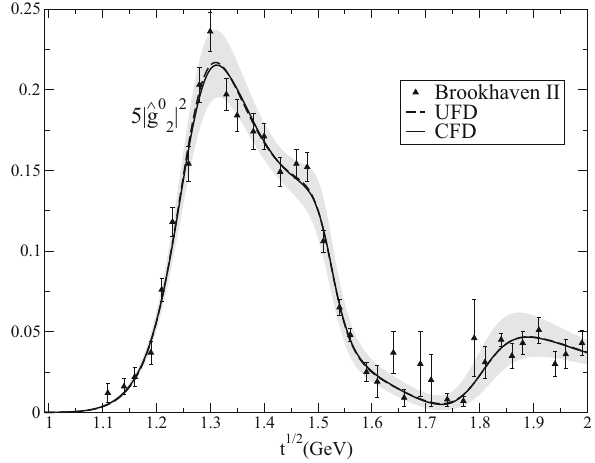
( t ) ππ → K ¯ K Fig. 11 Comparisonbetweentheinput(dashedline)andthedispersive 1 output (continuous line) for the modulus of the g 0 Eq.(47)usingasinputtheCFDset.Thegraybandcoverstheuncertainty of the difference